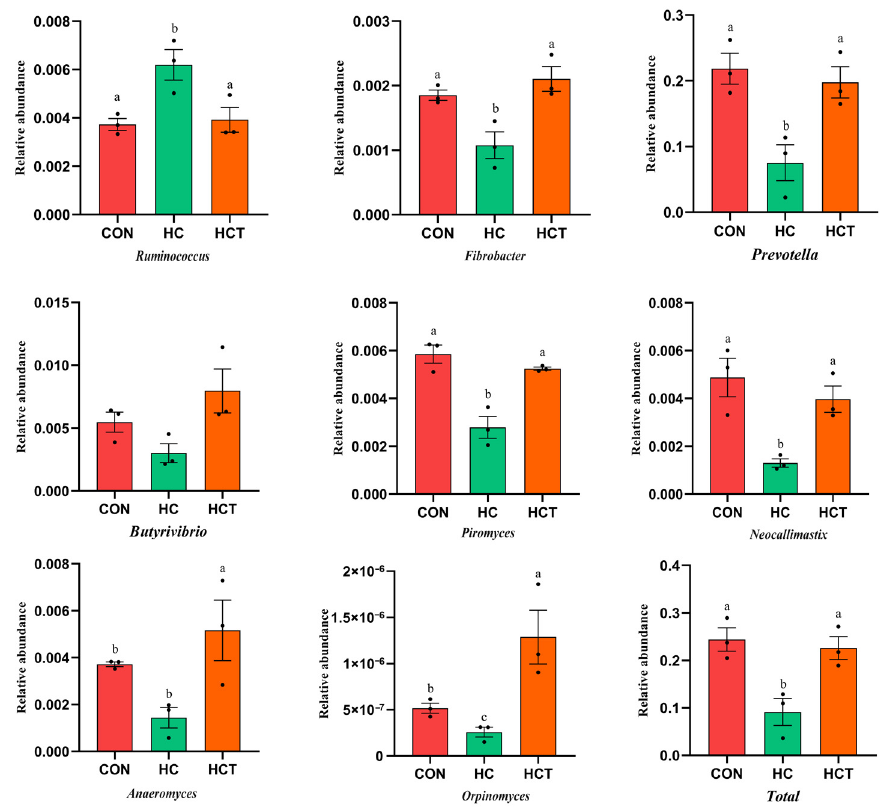
Figure 4. Effects of high-concentrate diet and thiamine supplementation treatment on the relative abundance of fiber-degrading microorganism. (a–c) Means with different letters differed significantly ( p < 0.05); the error bars represent the standard error of the mean. CON: Control diet; HC: High- concentrate die; HCT: High-concentrate diet supplemented with